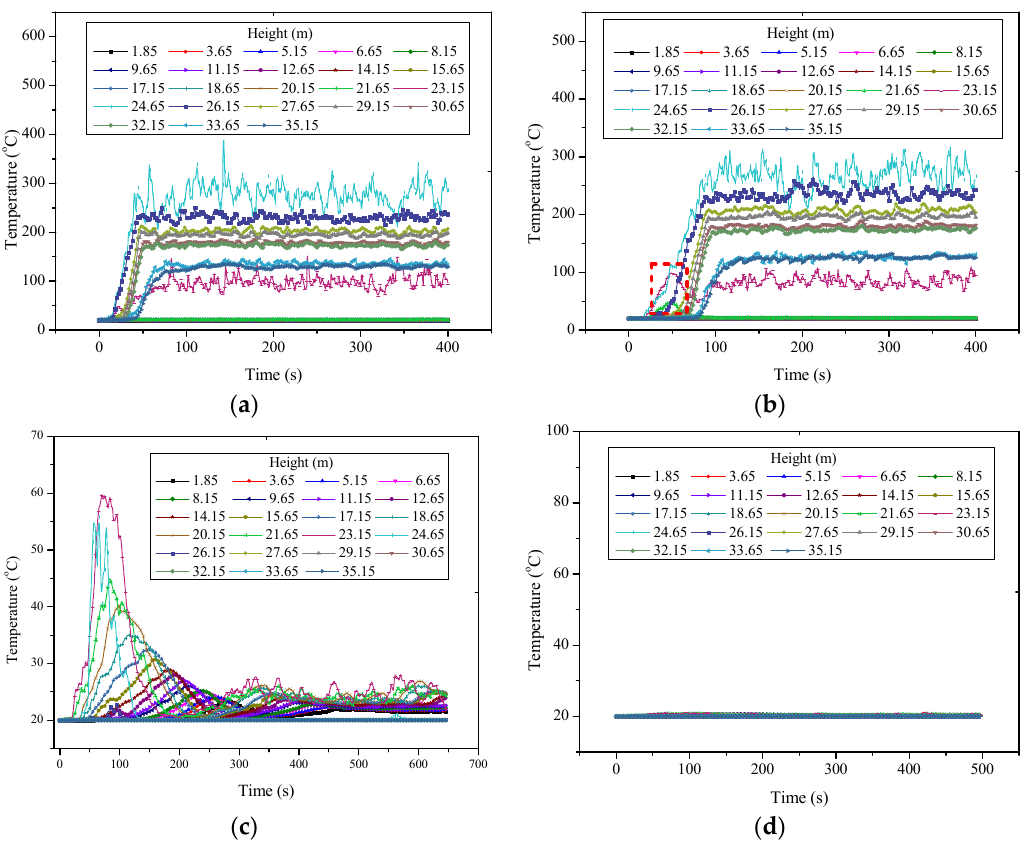
Figure 6. Vertical temperature profile versus time with open stair door on the 1st floor of 3 MW: ( a ) 0 m/s, ( b ) 3.5 m/s, ( c ) 4 m/s, and ( d ) 4.5 m/s.